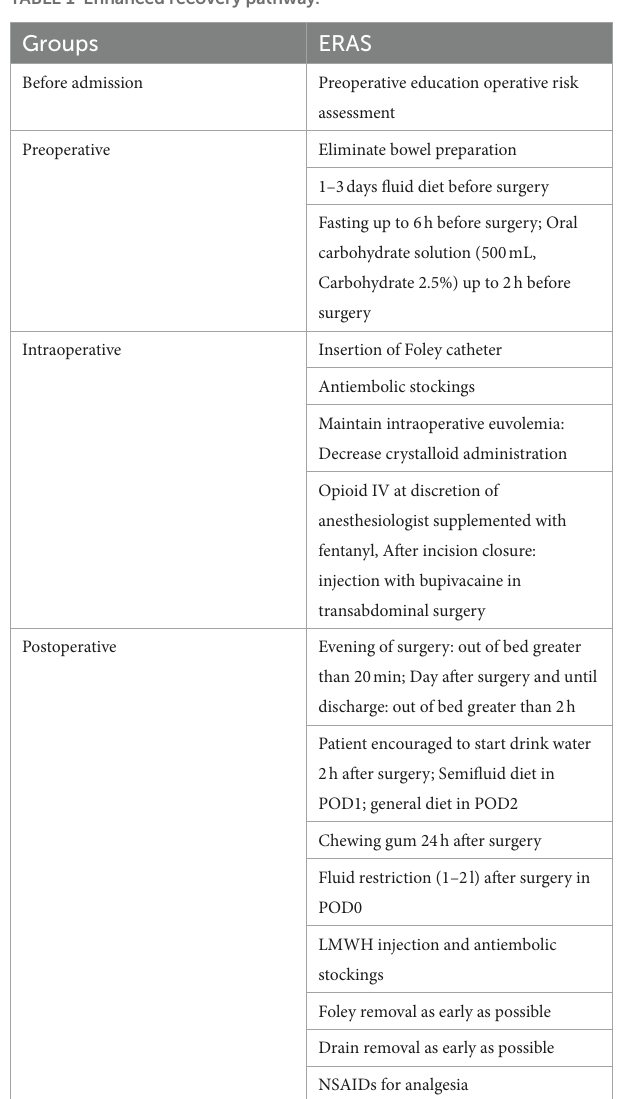
TABLE 1 Enhanced recovery